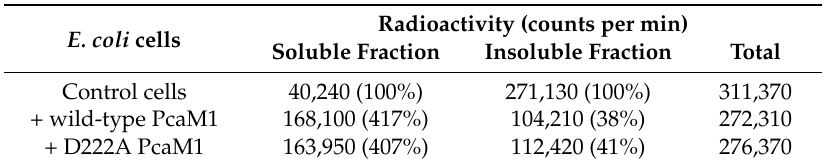
Table 2. Effects of PcaM1 variants on the cellular distribution of meso ‐ [ 14 C]A 2 pm incorporated into E. coli cells.